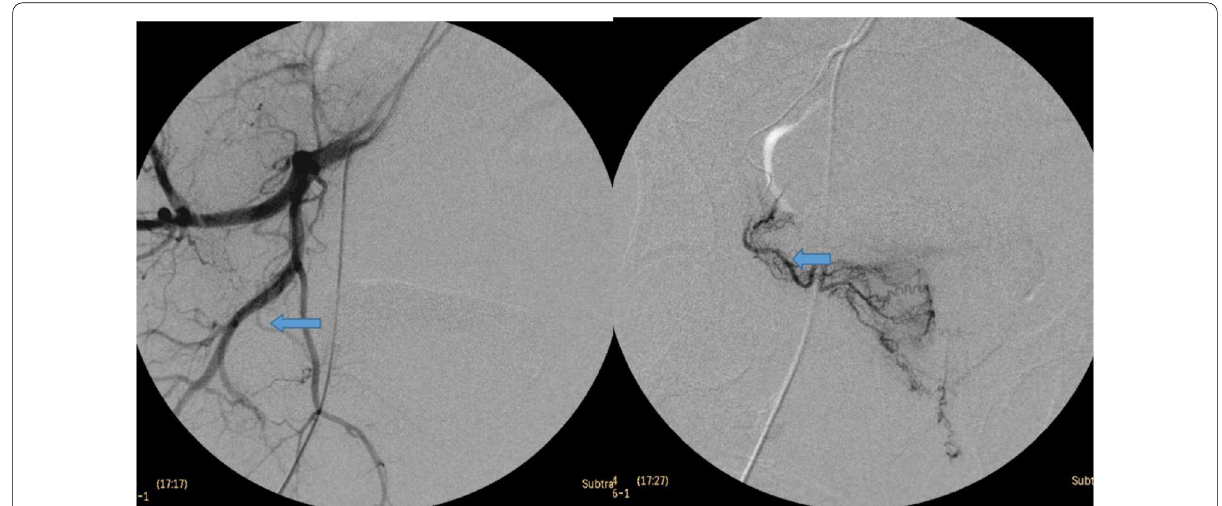
Fig. 14 Angiography images showing the origin of right prostatic artery (blue arrow) below superior vesical